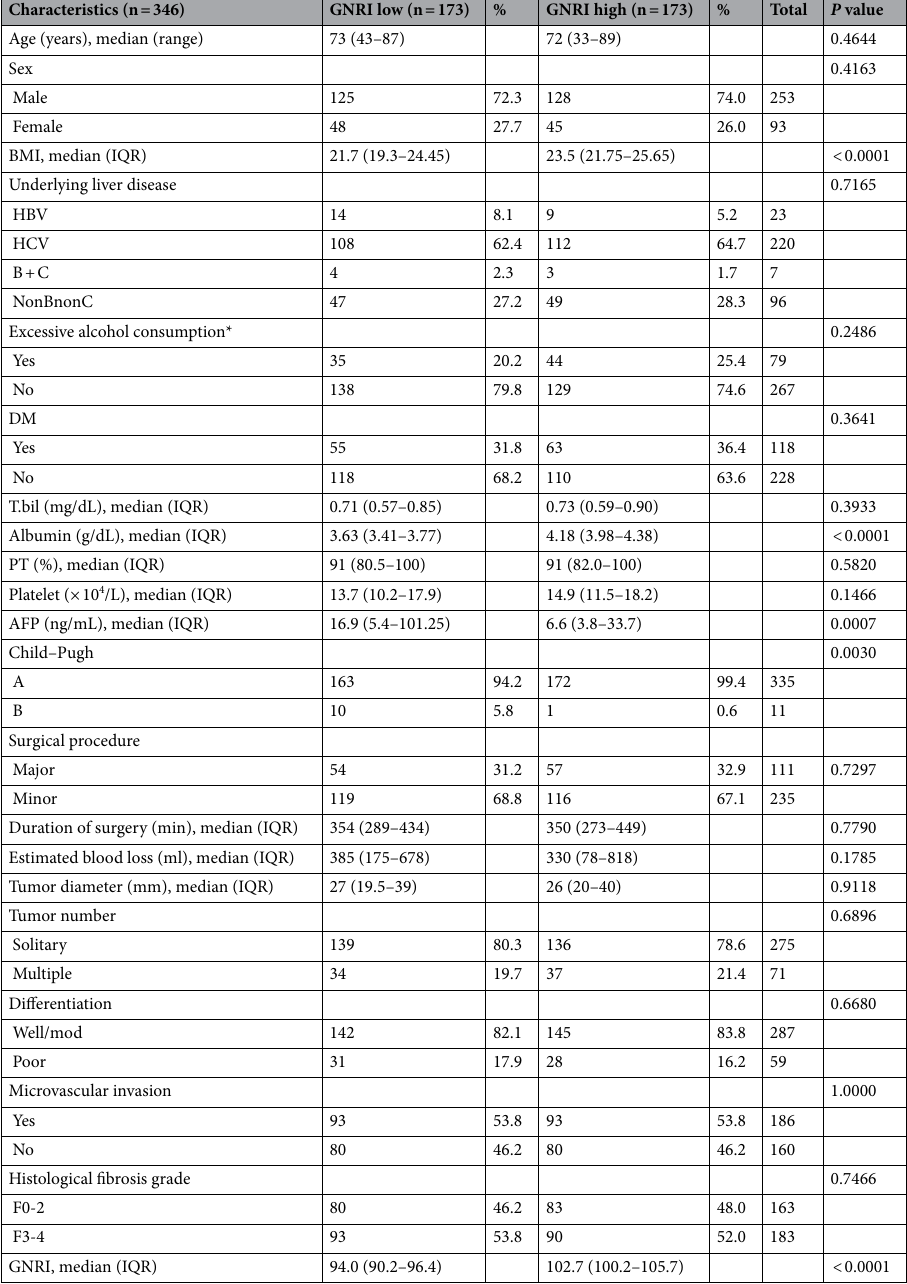
Table 1. Clinicopathological characteristics of the patients in the low- and high-GNRI groups after propensity score matching. *Excessive alcohol consumption is defined as > 28 g/day ethanol in men and > 14 g/day in women. AFP: alpha-fetoprotein, BMI: body mass index, DM: diabetes mellitus, GNRI: geriatric nutritional risk index, IQR: interquartile range, PT: prothrombin time, T.bil: total